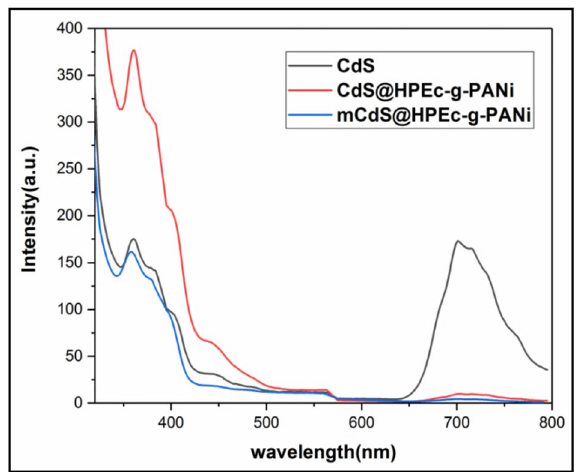
Figure 10. The PL spectra of the samples.